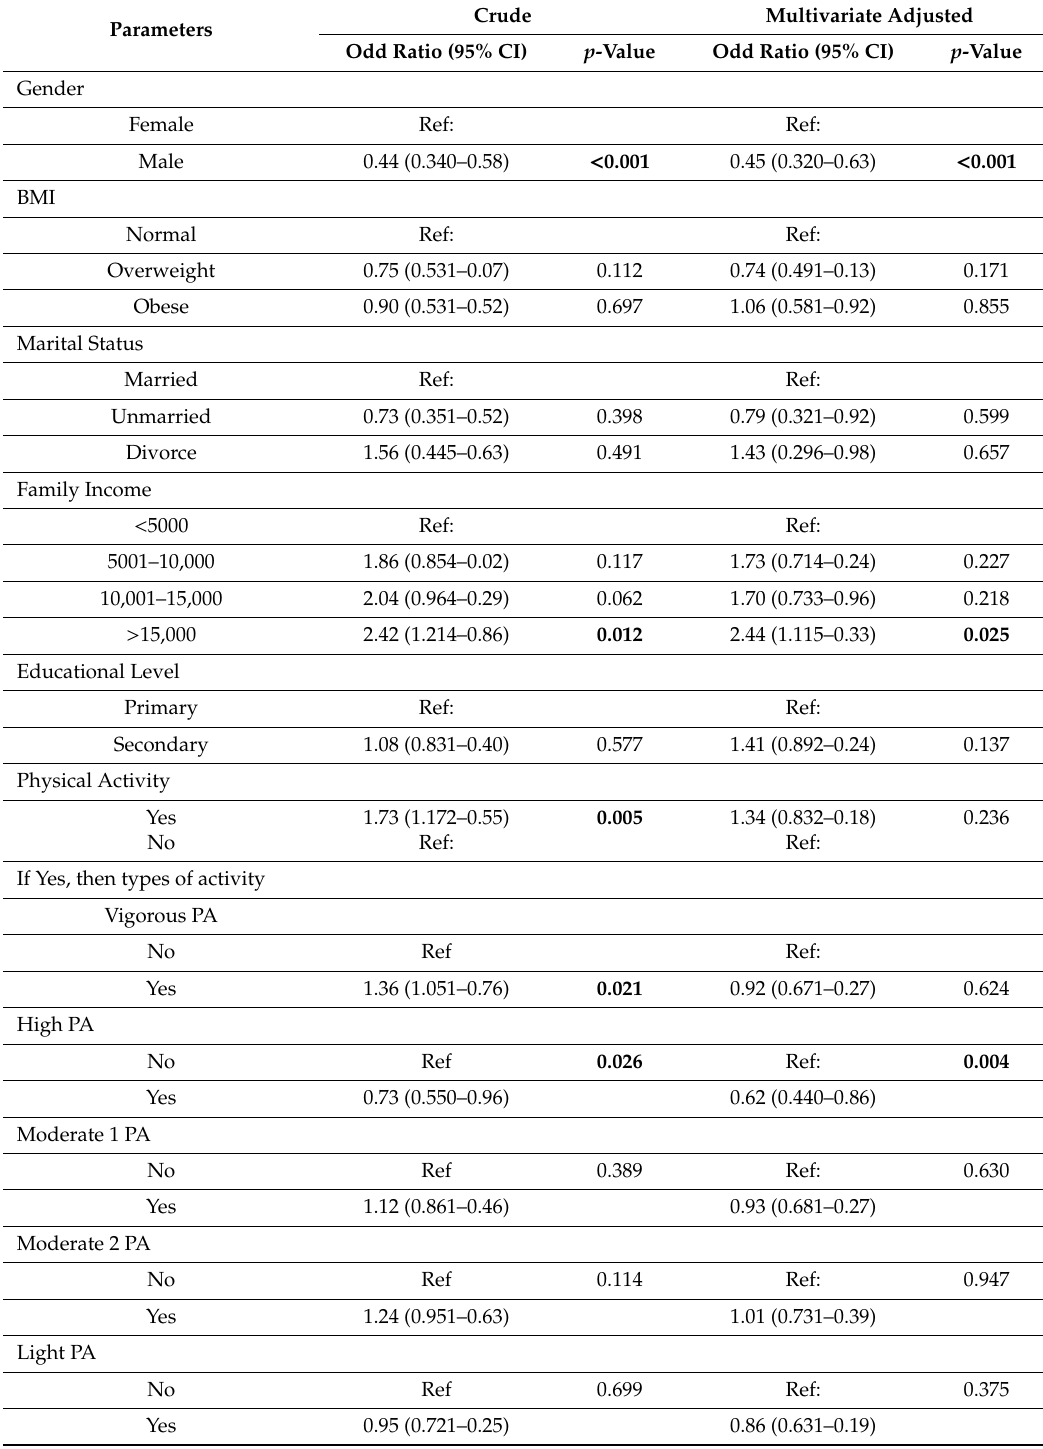
Table 6. Logistic regression investigating independent predictors of dietary supplement (DS) use in Saudi